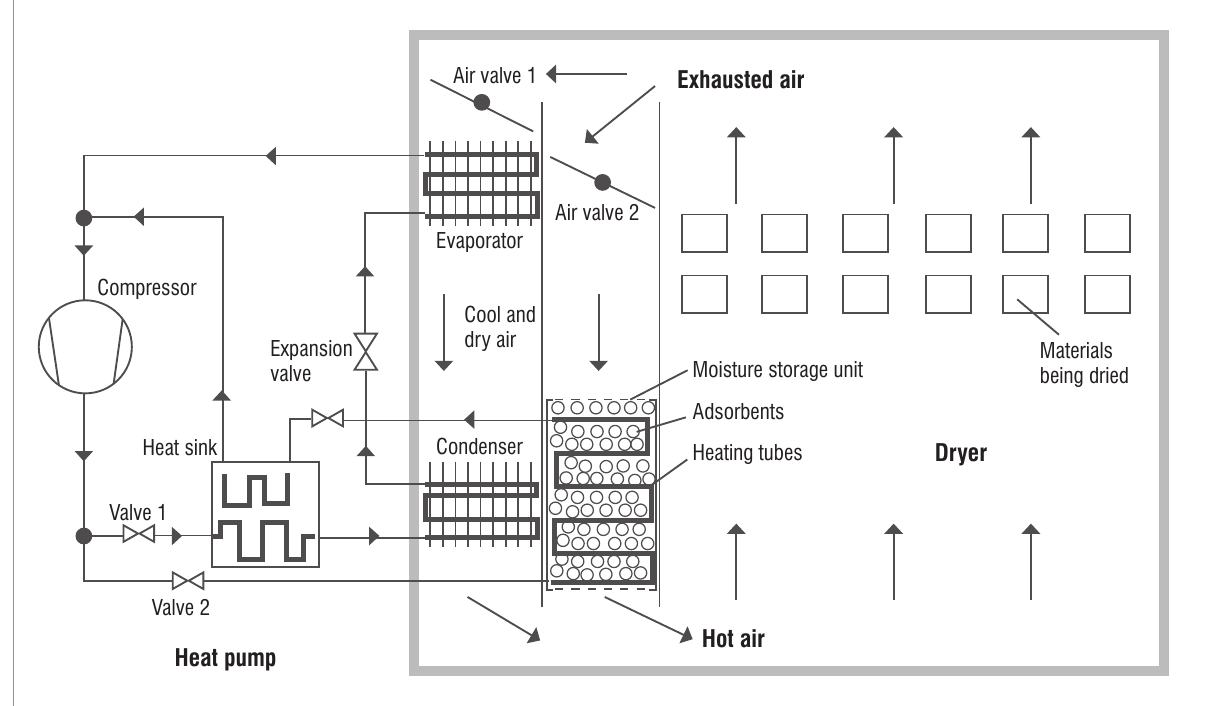
Figure 3: The desiccant-assisted heat pump